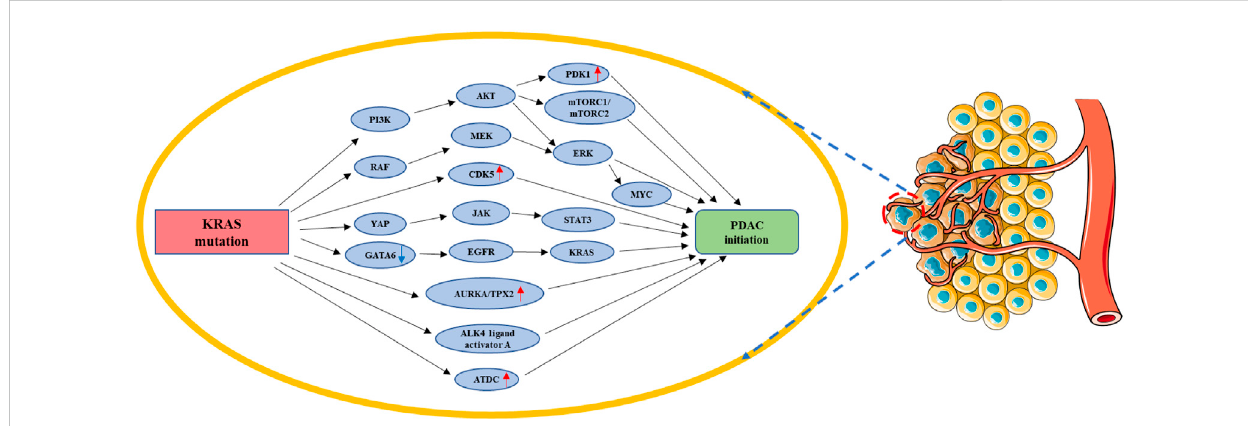
FIGURE 3 KRAS mutation in PDAC initiation. KRAS mutation could facilitate the transformation of acinar cells or ductal cells into pancreatic cancer cells by regulating PI3K/AKT/(PDK1&mTORC1/2&ERK-MYC), RAF/MEK/ERK, CDK5, YAP/JAK/STAT3, AURKA/TPX2, ALK4 ligand activator A, ATDC, and GA-TA6/ EGFR/ KRAS . Red arrow: The expression of related gene is upregulated. Blue arrow: The expression of related gene is